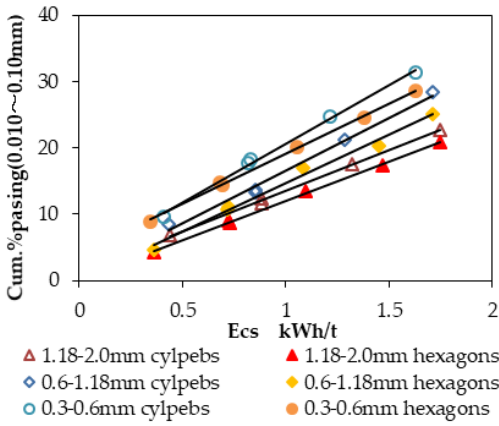
Figure 11. Mass percentage of 0.01–0.10 mm ground product in relation to specific energy.